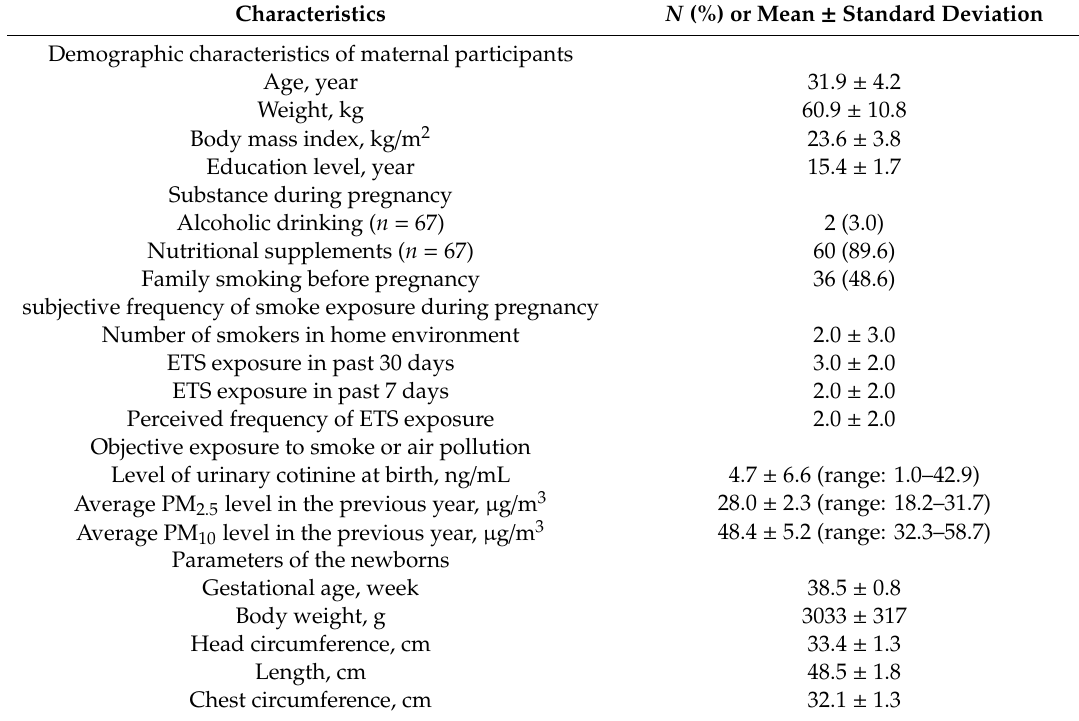
Table 1. Characteristics of the maternal participants and neonates ( N =